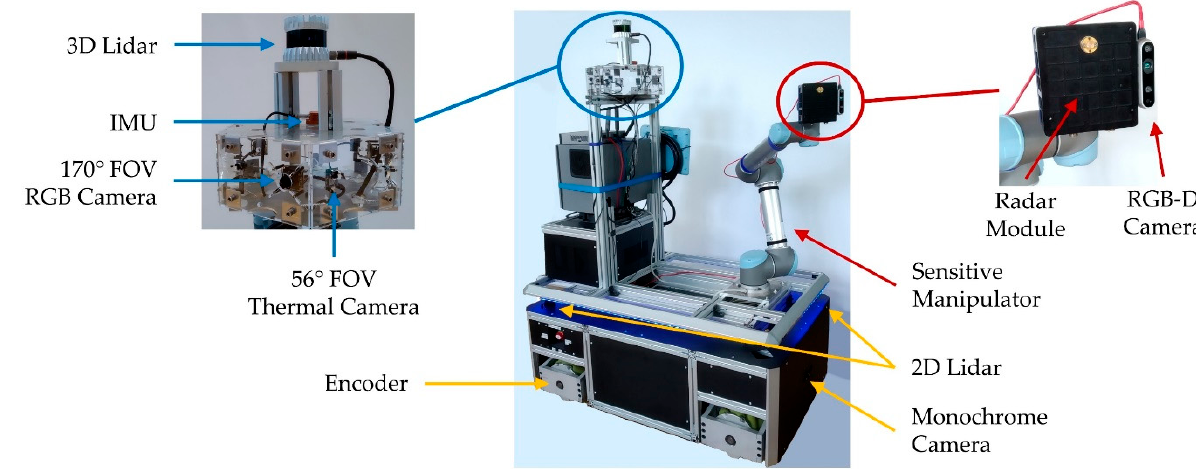
Figure 2. The AIMM OMNIVIL.